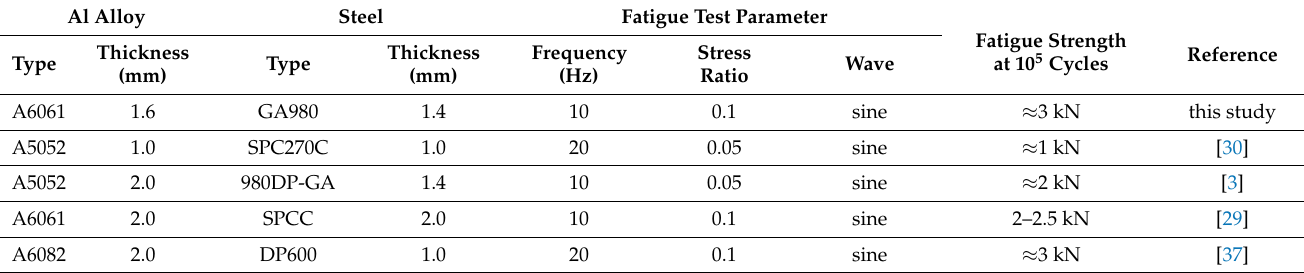
Table 3. Comparison of the fatigue strength of dissimilar FSSW joints with Al alloy and